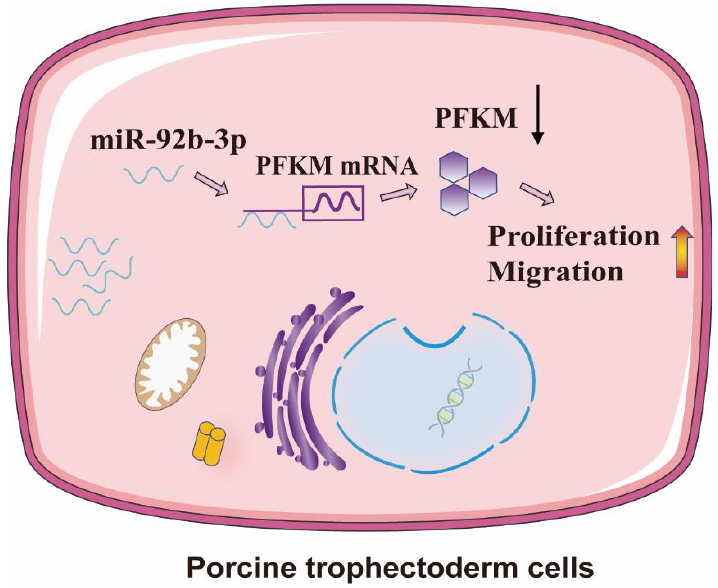
Figure 7. ssc-miR-92b-3p regulates porcine trophoblast cell proliferation and migration via the PFKM